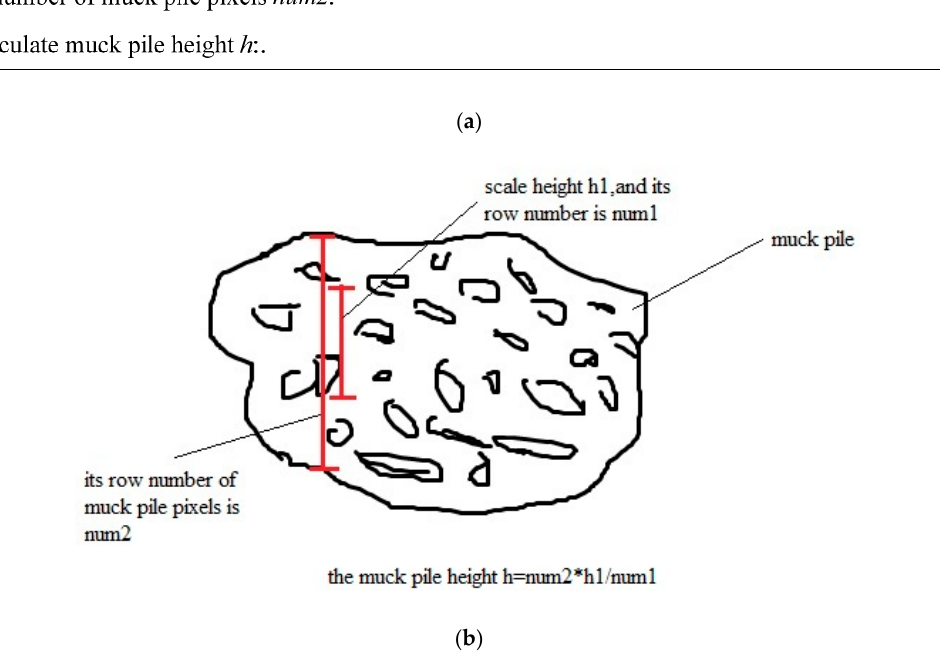
Figure 3. Muck pile height calculation: ( a ) The algorithm; ( b ) The explanation.